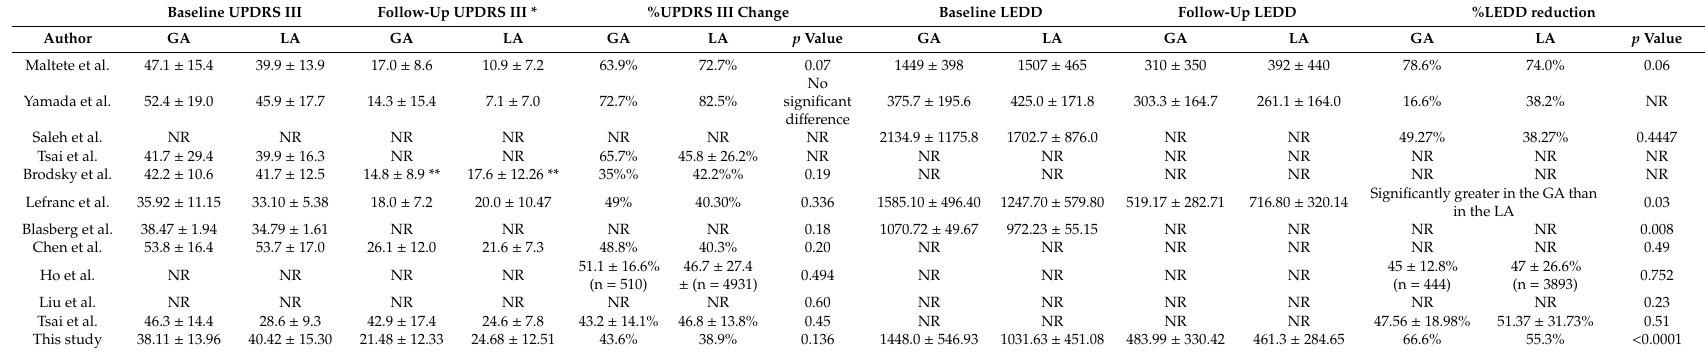
Table 3. Summary data of published literature comparing clinical outcome e ff ect of after subthalamic nucleus deep brain stimulation under general anesthesia and local anesthesia in patients with Parkinson’s disease: Baseline and Follow-up Unified Parkinson’s Disease Rating Scale (UPDRS) III score and Levodopa equivalent daily dose (LEDD).